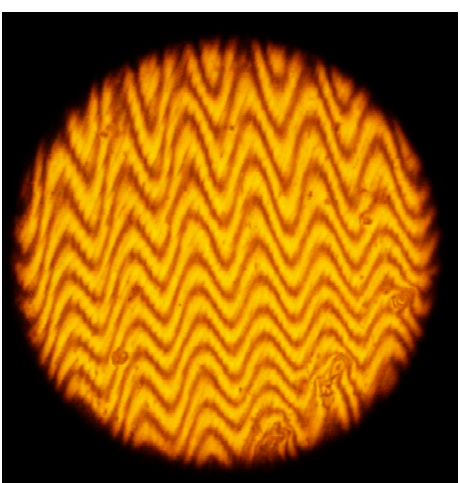
Figure 16. Gratings relief was investigated with an interference microscope. Photograph shows the relief of a PVA/PAA grating.